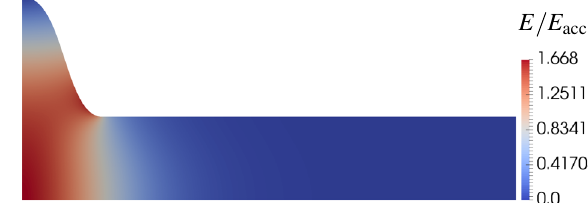
FIG. 16. The electric field of the FM in half of the chosen B´ezier cavity.